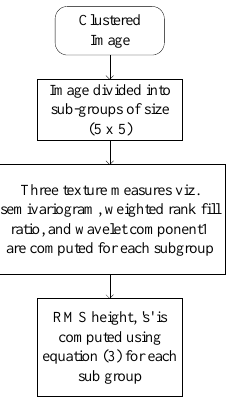
Figure 2. Flow chart for computing RMS height 's'